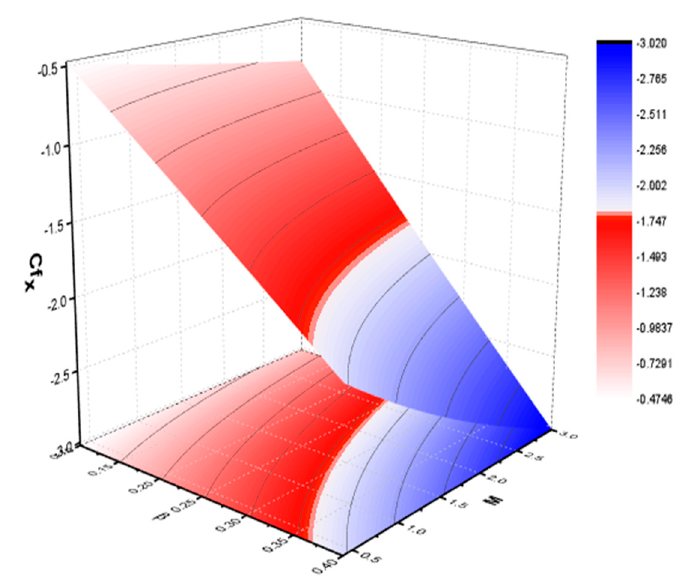
Cf for β and M . β and M .